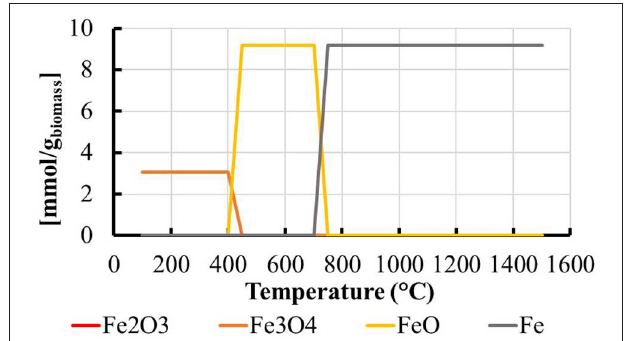
FIGURE 4 | Quantity of iron species obtained at thermodynamic equilibrium per gram of dry biomass from gasification of wood with iron oxide in stoichiometric proportion ( C 6 H 9 O 4 + 2 Fe 2 O 3 ) according to 3